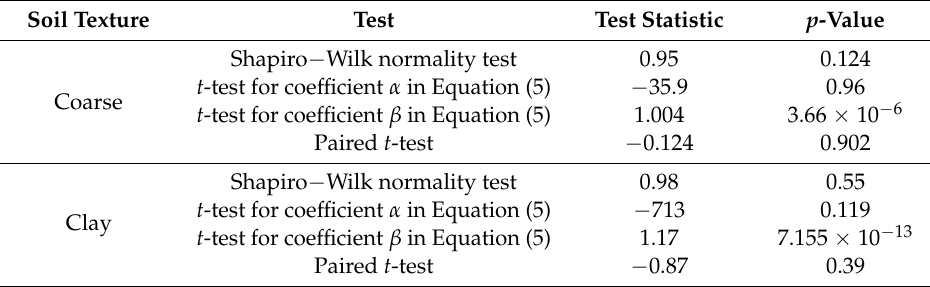
Table 4. Summary of the statistical tests for the model validation